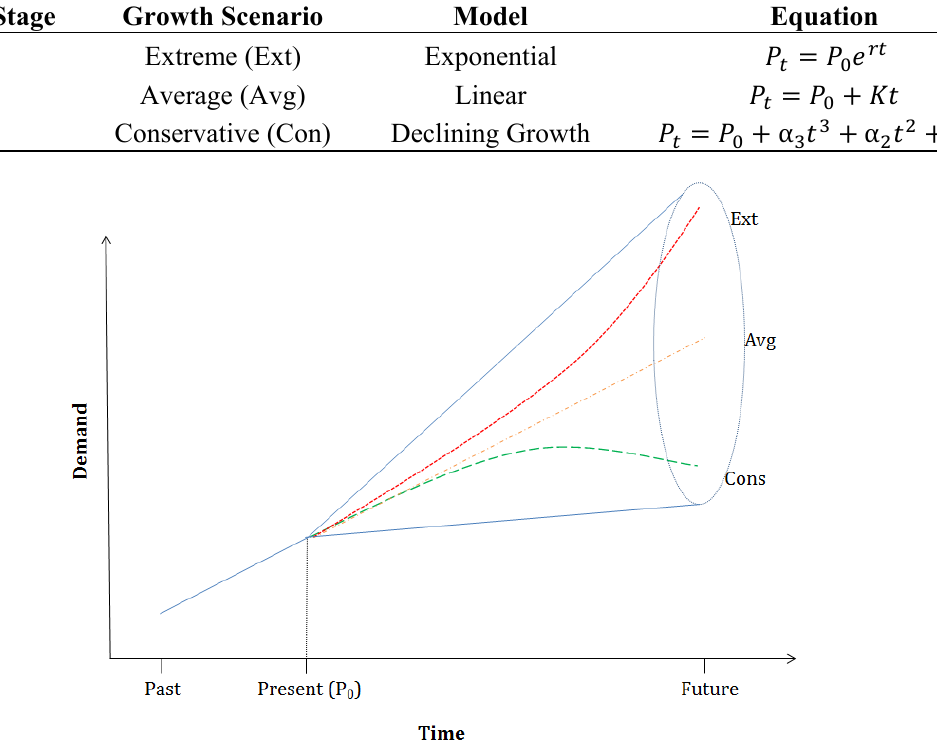
Figure 1. Generic “demand cone” of future trajectories; extreme (Ext), average (Avg), and conservative (Cons)